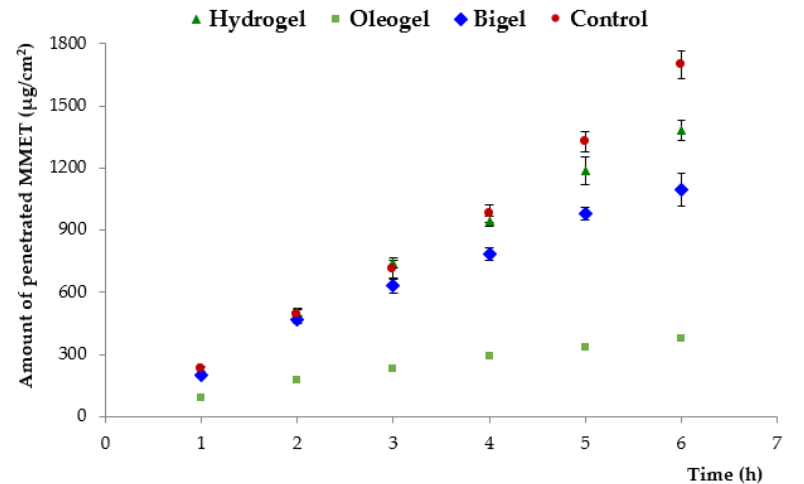
Figure 7. Penetration of MMET from hydrogel, oleogel and bigel formulations as compared to commercially available ointment with MET through porcine buccal mucosa (expressed as the amount of drug penetrated per unit of tissue area to acceptor